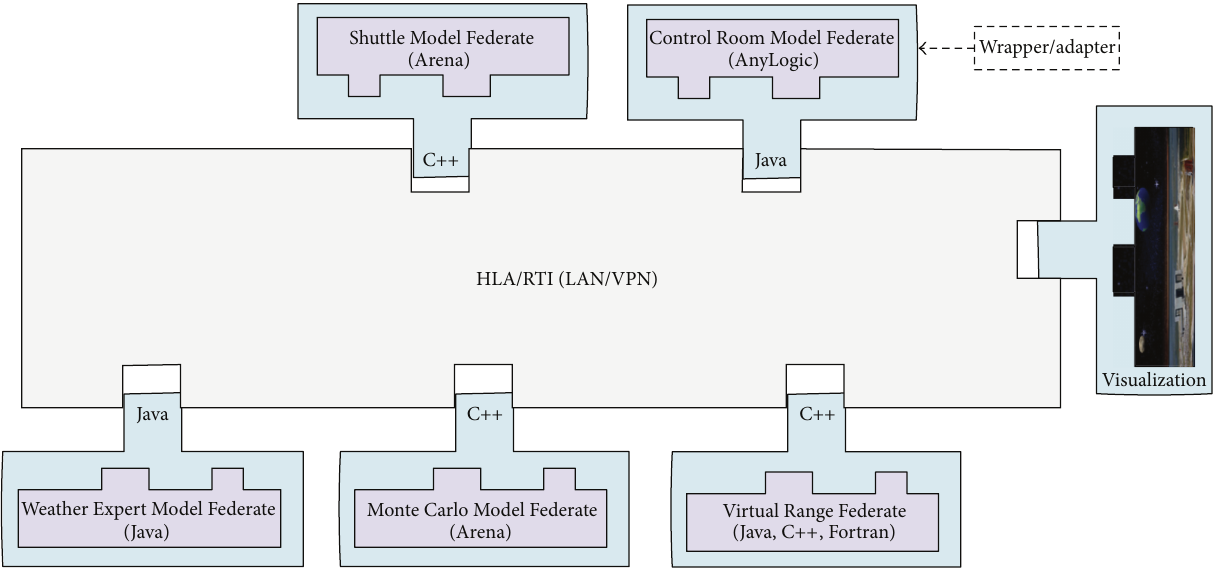
Figure 1: Space shuttle distributed simulation configuration using HLA/RTI (local area network (LAN)/virtual private network